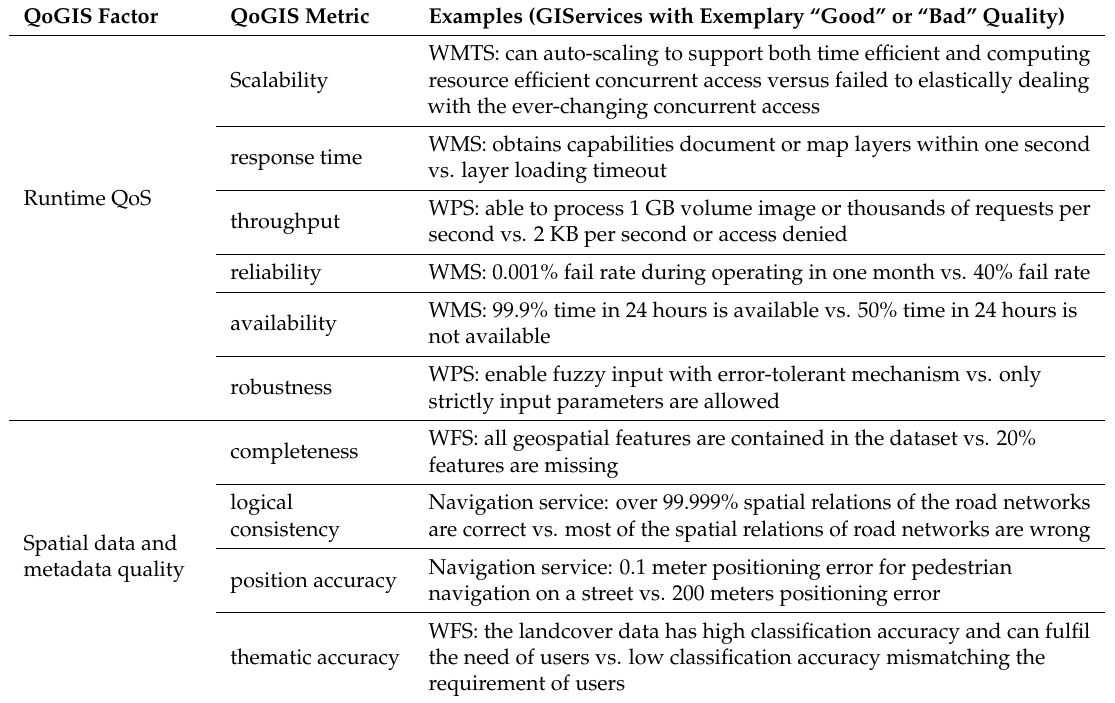
Table A2. Catalogue of QoGIS Quality Metric with GIService Examples with Good or Bad Quality. QoGIS